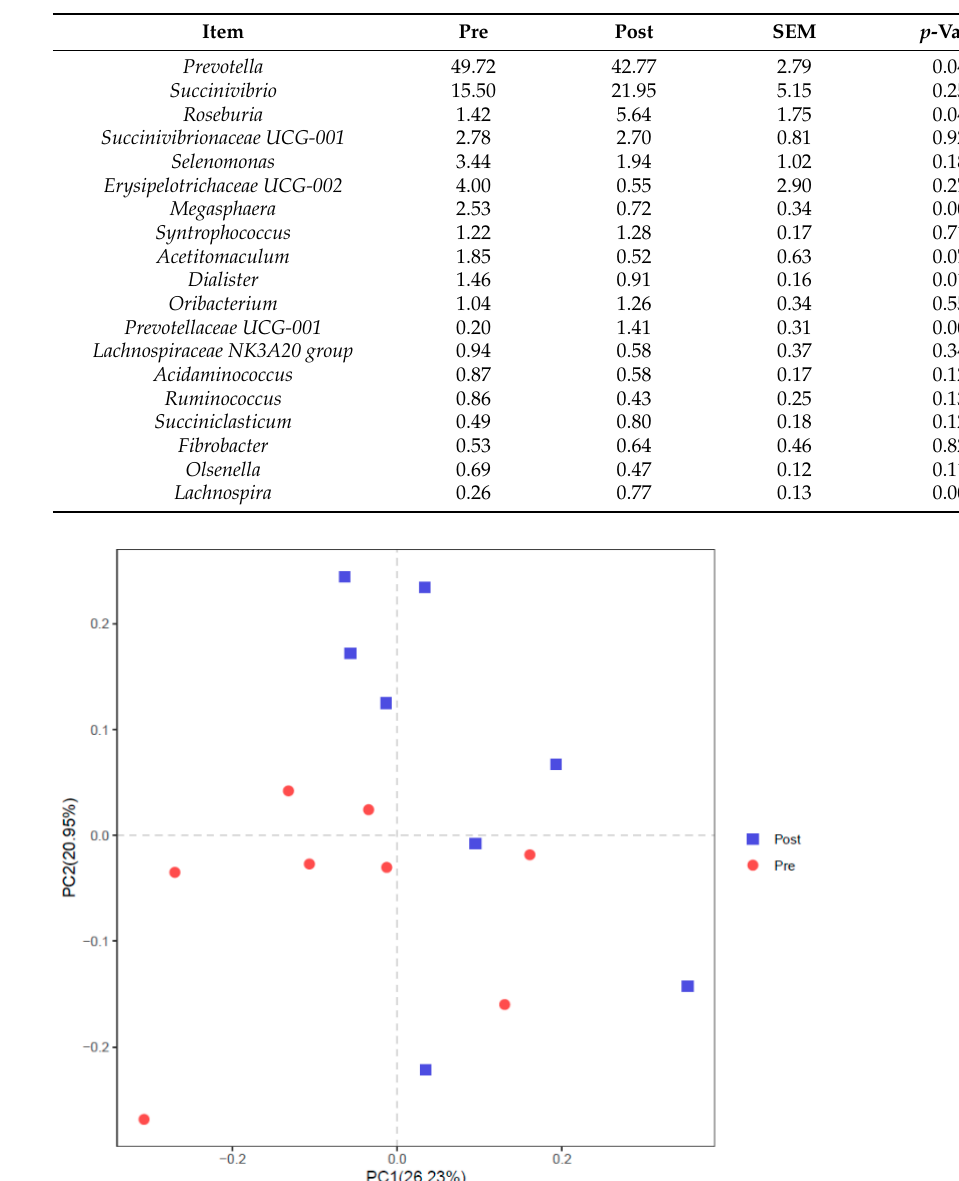
Figure 6. Non-metric multidimensional scaling (NMDS) of rumen bacterial community before (Pre) and after (Post) diet shift.